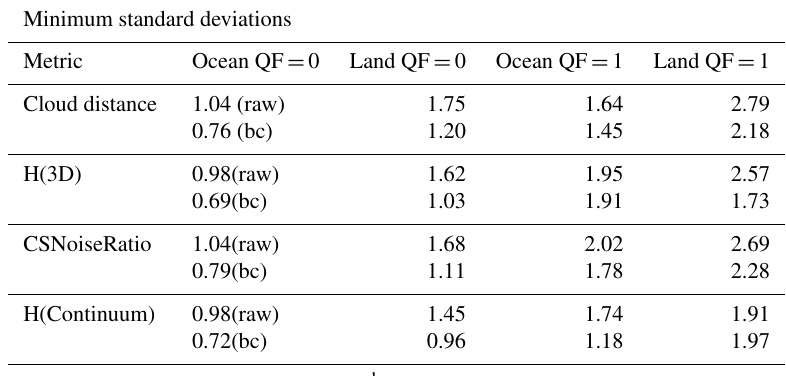
Table 4. Minimum standard deviations (ppm) and ranges of the ratios of the version 10 XCO2–TCCON standard deviations a